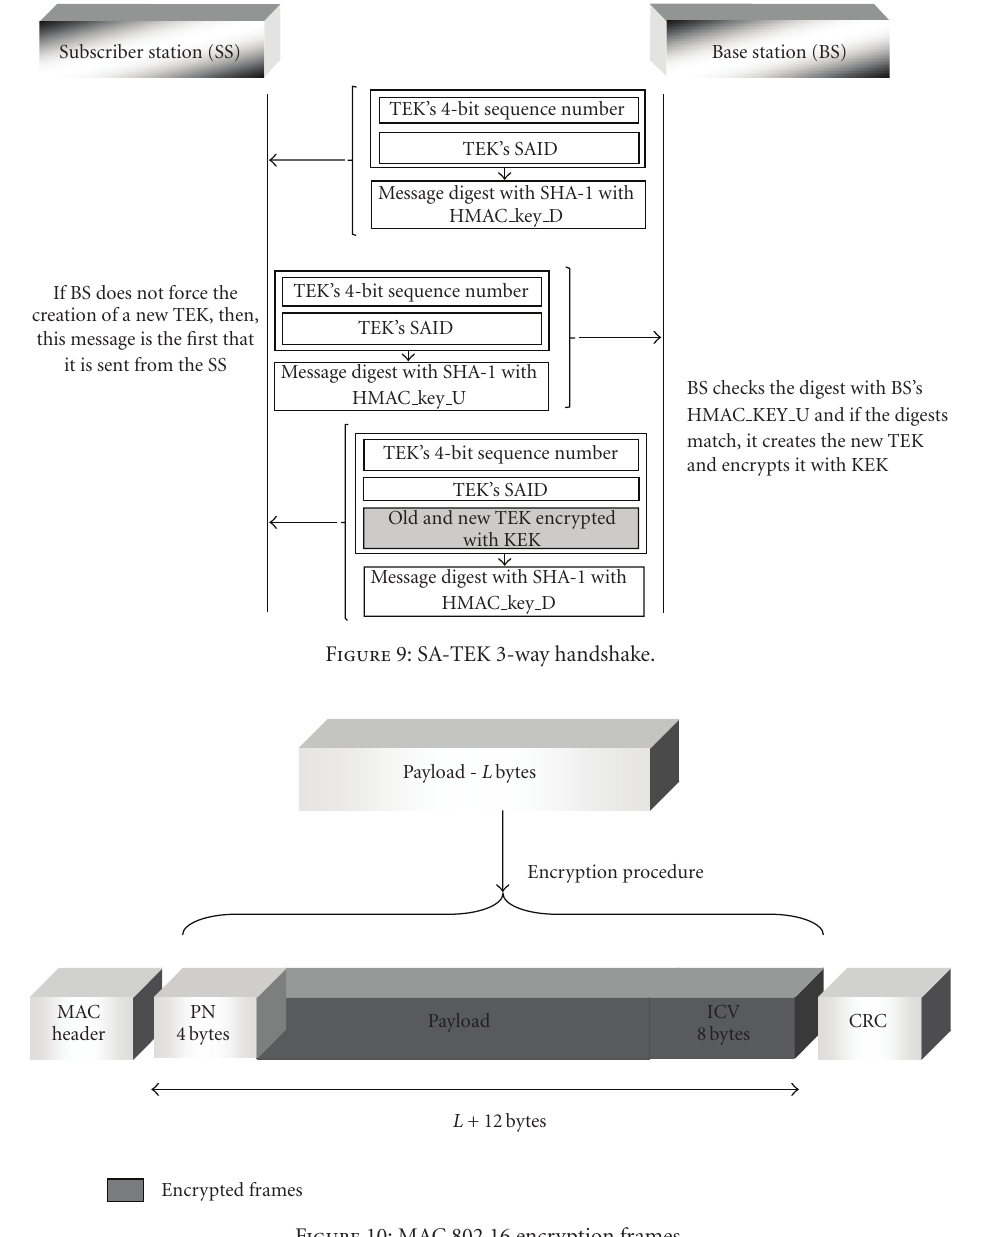
Figure 10: MAC 802.16 encryption